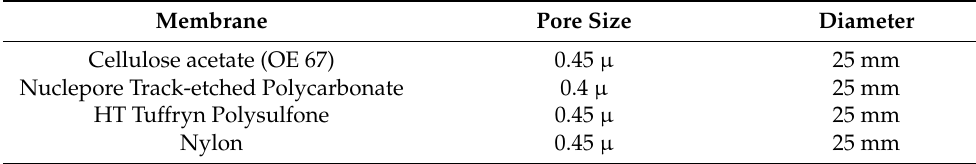
Table 2. Commercially available membranes and their dimensions.